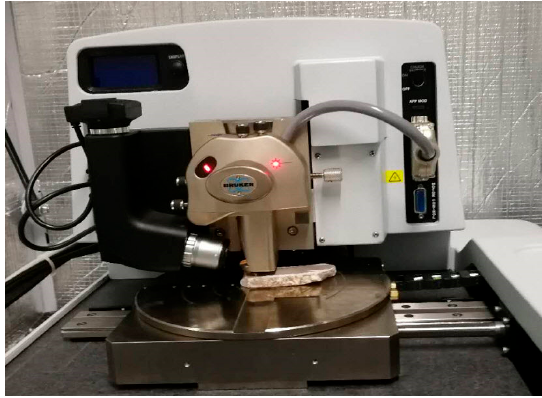
Figure 4. Atomic force microscopy (AFM) system.